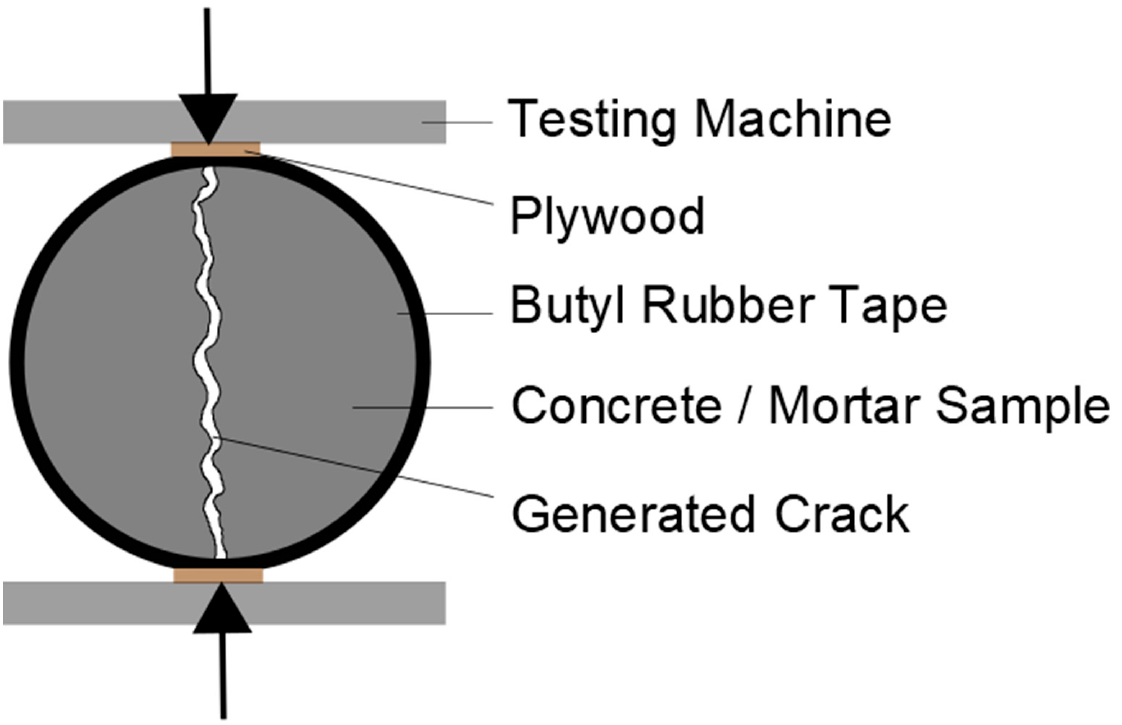
Figure 3. Scheme of the crack generation test setup.